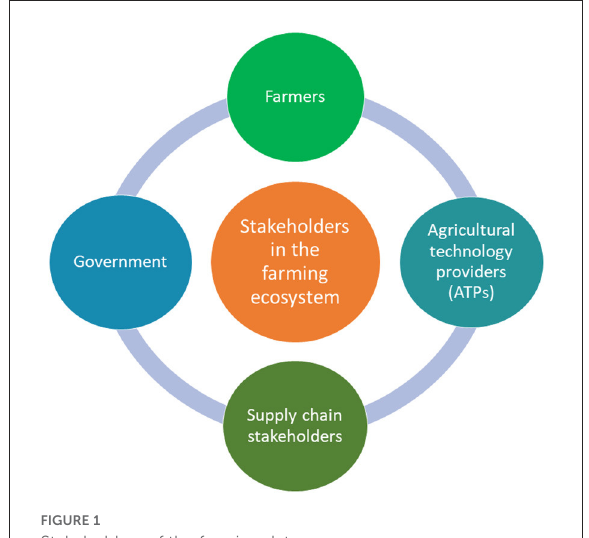
FIGURE1 Stakeholders of the farming